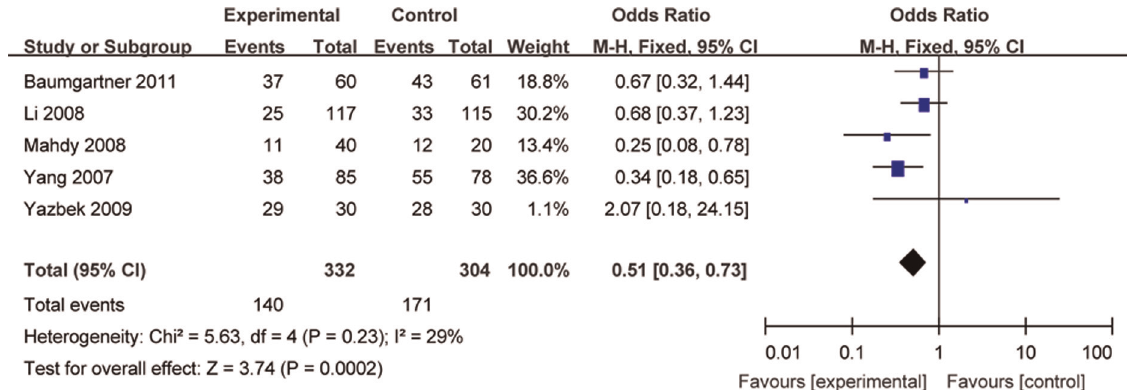
Figure 4 - CS after preserving T2 in sympathectomy. CI, confidence interval; CS,